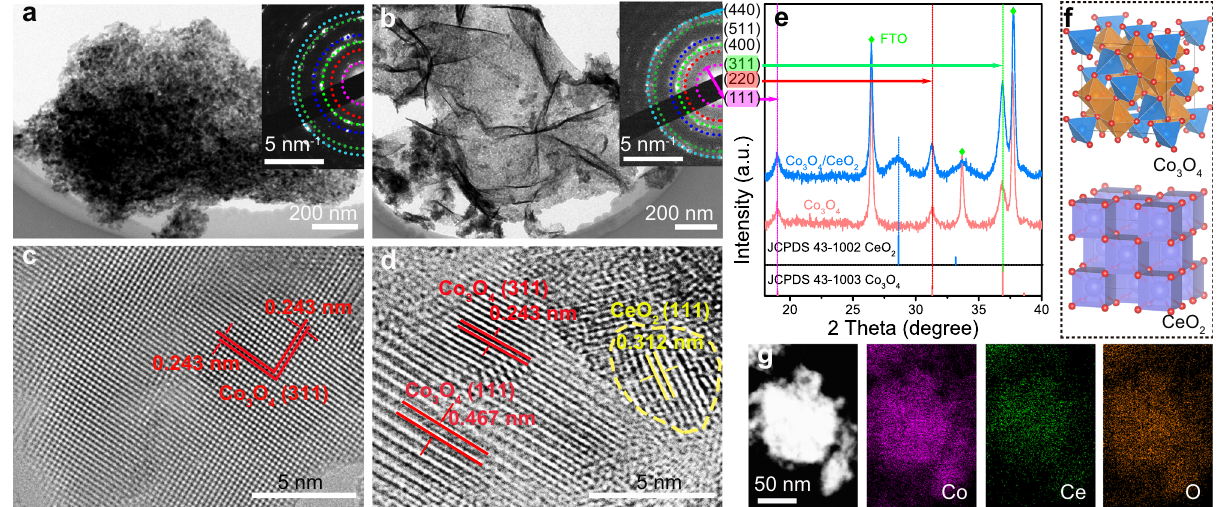
Fig. 1 Structural characterizations of Co 3 O 4 nanostructures and Co 3 O 4 /CeO 2 nanocomposites. TEM images of a Co 3 O 4 and b Co 3 O 4 /CeO 2 nanosheets, the insets show the corresponding SAED patterns. HRTEM images of c Co 3 O 4 and d Co 3 O 4 /CeO 2 samples. The CeO 2 domain is highlighted with a yellow dashed circle. e PXRD patterns of the samples on FTO substrates in comparison with the standard PXRD patterns of Co 3 O 4 (JCPDS 43-1003) and CeO 2 (JCPDS 43-1002). f Crystal structures of Co 3 O 4 and CeO 2 . g Dark- fi eld TEM image and the corresponding elemental mappings of Co, Ce, and O in the Co 3 O 4 /CeO 2